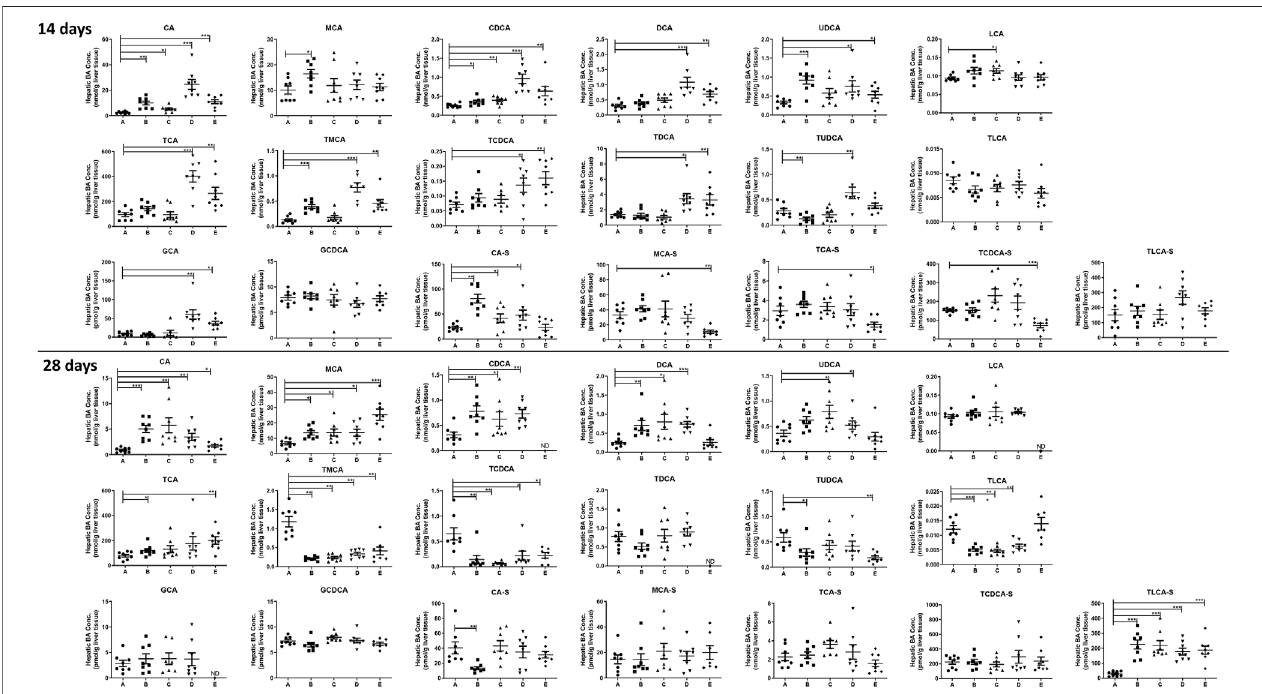
FIGURE 2 | Concentration of the individual BAs in the mouse liver after the anthraquinones or PMR consumption for 14 or 28 days (A: control, B: emodin, C: chrysophanol, D: physcion, E: PMR). The data are expressed as the mean ± SD (n = 6 – 8). * p < 0.05, ** p < 0.01, *** p < 0.001 compared with control group, ND: not